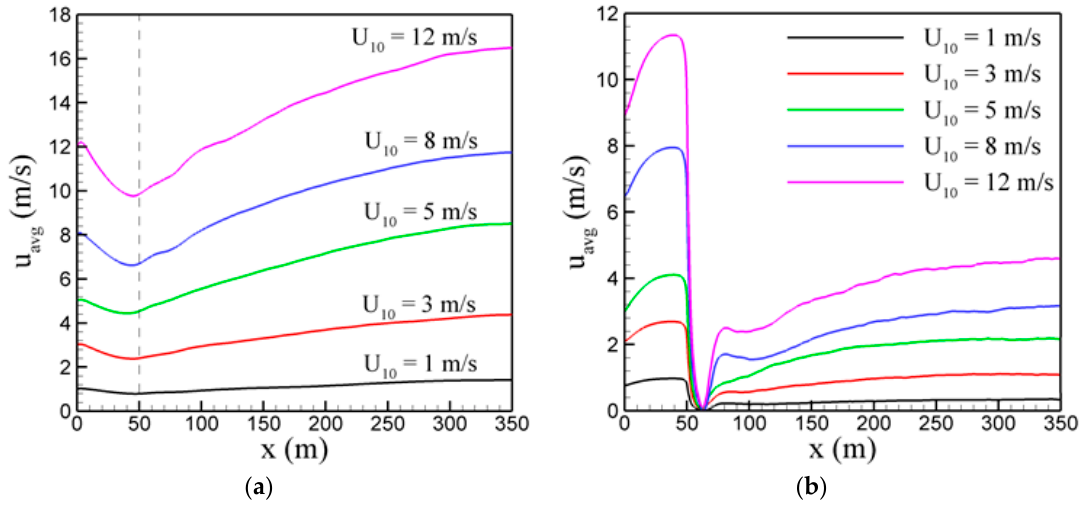
Figure 8. Variation in the x -direction of the averaged stream-wise velocity component u obtained ( a ) at the canopy-top surface ( z = H ) and ( b ) at the grassland-top surface (z = h ), for canopy LAI = 2 and for different wind speeds. u ( x ) was time-averaged between t = 800 s and t = 1000 s as well as in the y -direction.